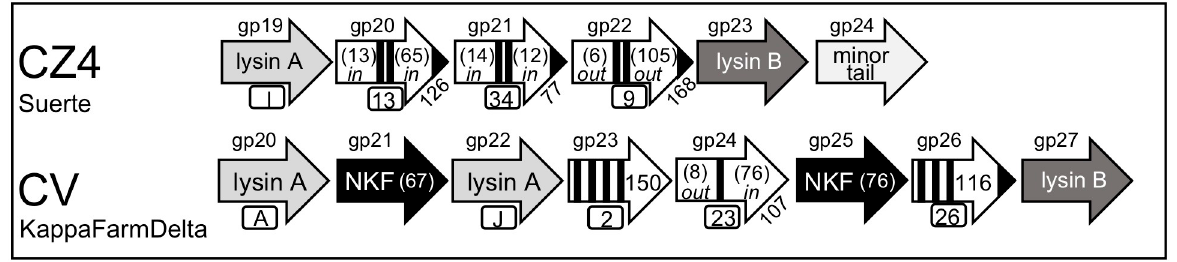
Fig 7. Genomic organization lysis cassettes with a three transmembrane genes flanked by lysA and lysB . The genomic structure is shown and the key to the schematic is presented in Fig 1. The direction of transcription of each gene is represented by the arrowhead.